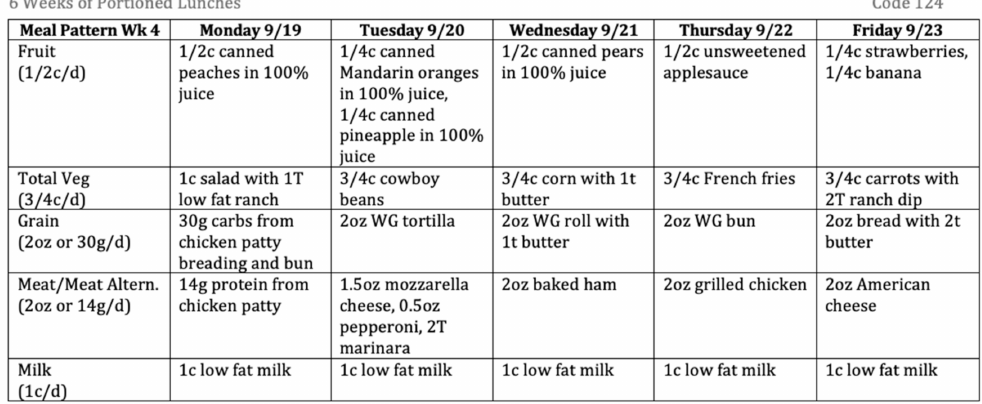
Figure 1. Image of a one-week sample of a portioned middle school lunch